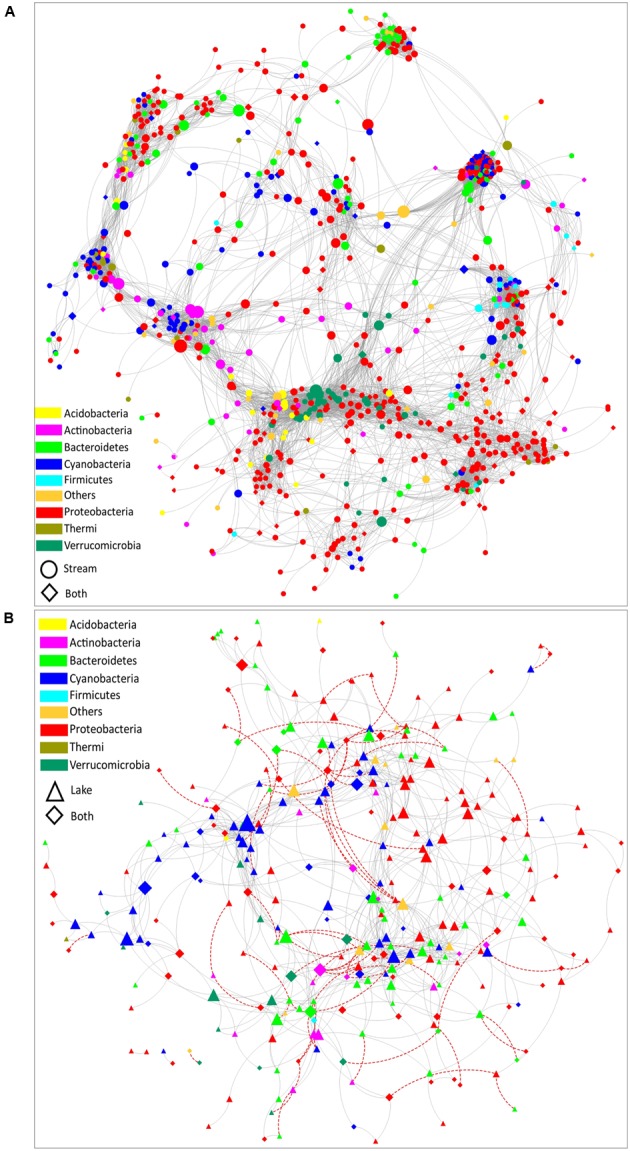
The co-occurrence network of bacterial communities in (A) stream biofilms and (B) lake water. Edges represent correlation relationships. Gray solid lines indicate positive associations (co-occurrence interactions) and red dashed lines indicate negative associations (co-exclusion interactions). Only strong and significant relationships (spearman R > 0.7 or R < –0.7, P < 0.01) are shown. Nodes are sized by the OTU betweenness and colored by phylum. Circle nodes represent OTUs with a relative abundance higher than 0.01% only in the stream samples. Triangle nodes represent the OTUs with a relative abundance higher than 0.01% only in the lake samples. Diamond nodes represent the OTUs with a relative abundance greater than 0.01% in both lake and stream samples.